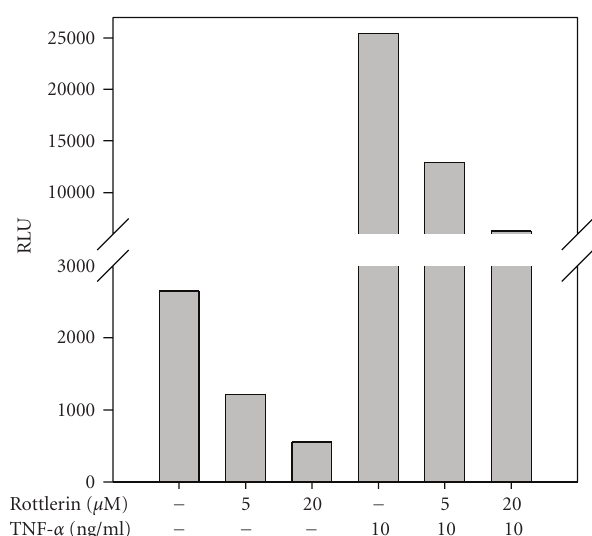
Figure 5: Rottlerin prevents both basal and induced intracellular production of H 2 O 2 . MCF-7 cells were pretreated with 5 and 20 μ M Rottlerin for 1hr and loaded by H 2 O 2 -specific fluorescent probe DHR-123. Cells were treated with menadione (100 μ M) and hydrogen peroxide (100 μ M) for 30min and analyzed using flow cytometry.